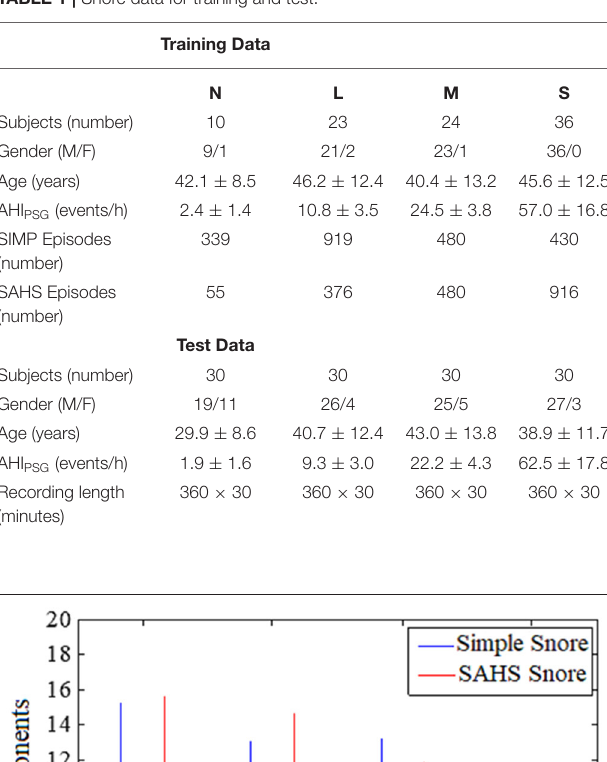
TABLE 1 | Snore data for training and test.